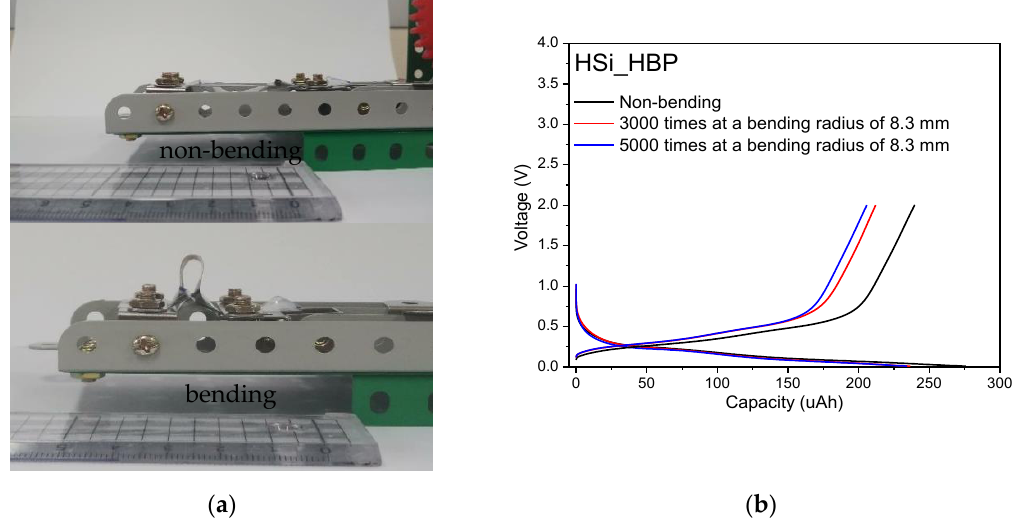
Figure 10. Bending-state electrochemical testing of HSi_HBP electrodes. ( a ) Photograph of bending test for 8.3 mm radius at two different durations; ( b ) Charge/discharge capacity profiles of electrodes at a current density of 125 μA with the voltage ranges of 0.01–2.0 V.